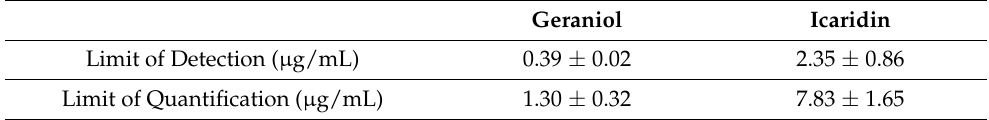
Table 2. Limit of detection and limit of quantification of the analytical methods for geraniol and